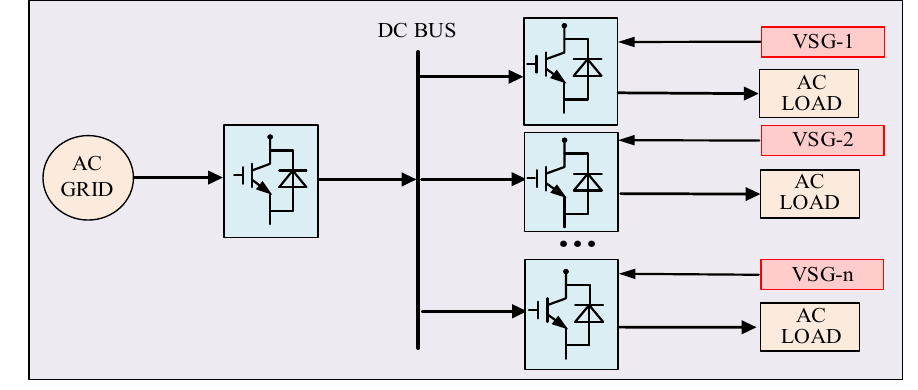
Figure 3. DC distribution grid.